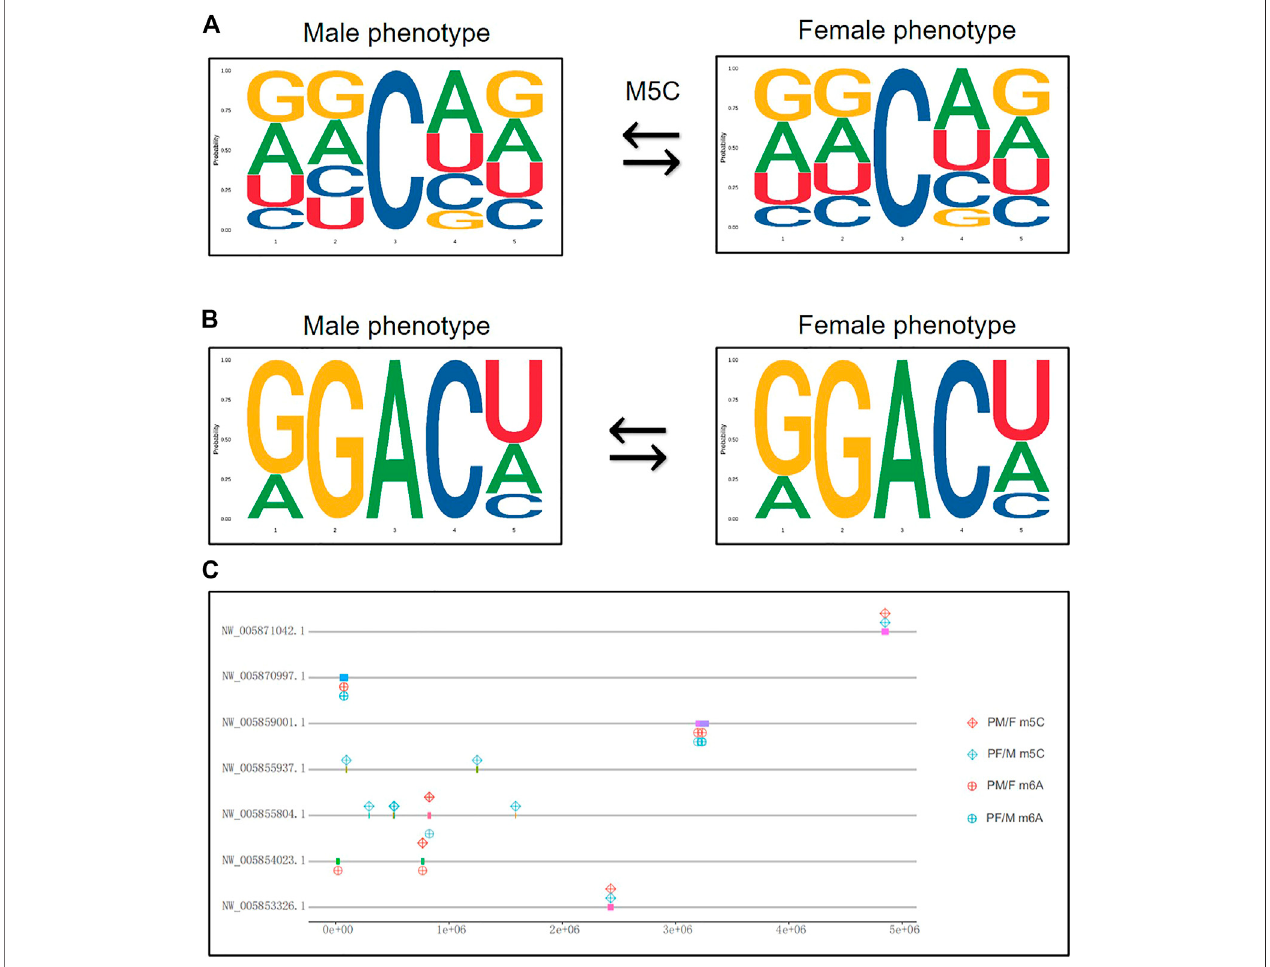
FIGURE 6 | The chromosomal location of methylated modi fi cation sites. (A) The genetic features of the 5 bp long m5C methylation sites from male phenotype to female phenotype. (B) The genetic features of the 5 bp long m6A methylation sites from male phenotype to female phenotype. The abscissa represents the number of bases at the methylation site, the total height of each position is the sequence conservation of the bases, and the height of the base signal represents the relative frequency of the base at that position. (C) The chromosomal location of differential methylated gens both in m5C and m6A related sexual reversal process.